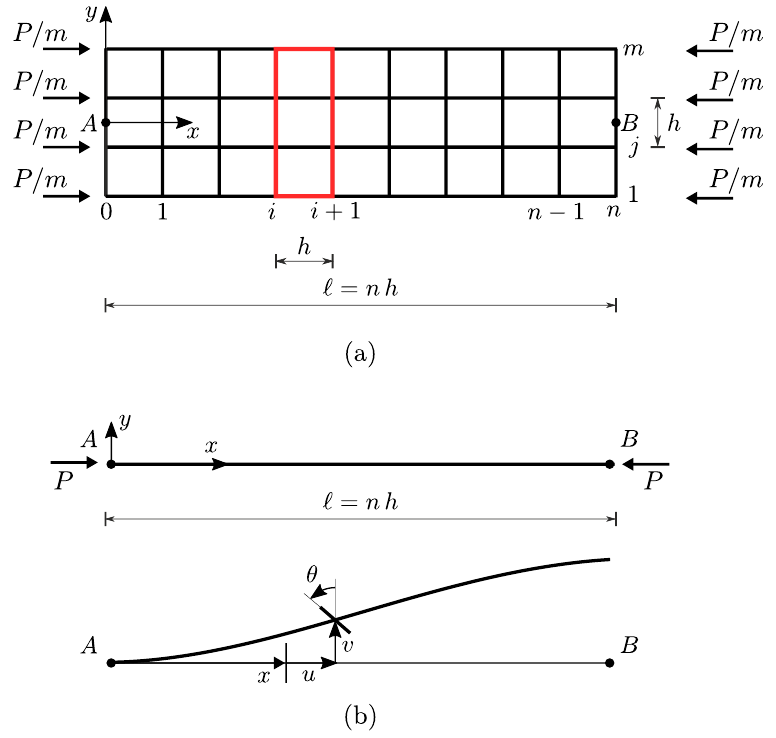
Figure 1. Study object: ( a ) grid beam; ( b ) equivalent beam model in the reference and current